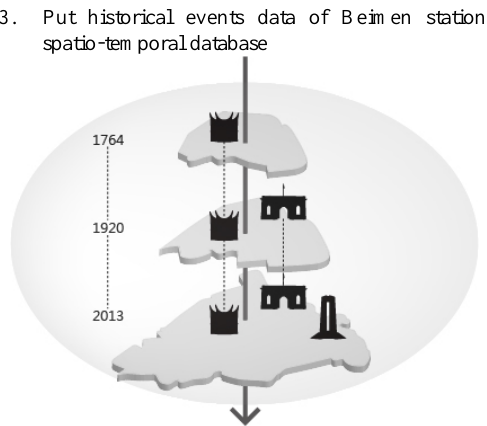
Figure 2. Historic building used as the interface from past to